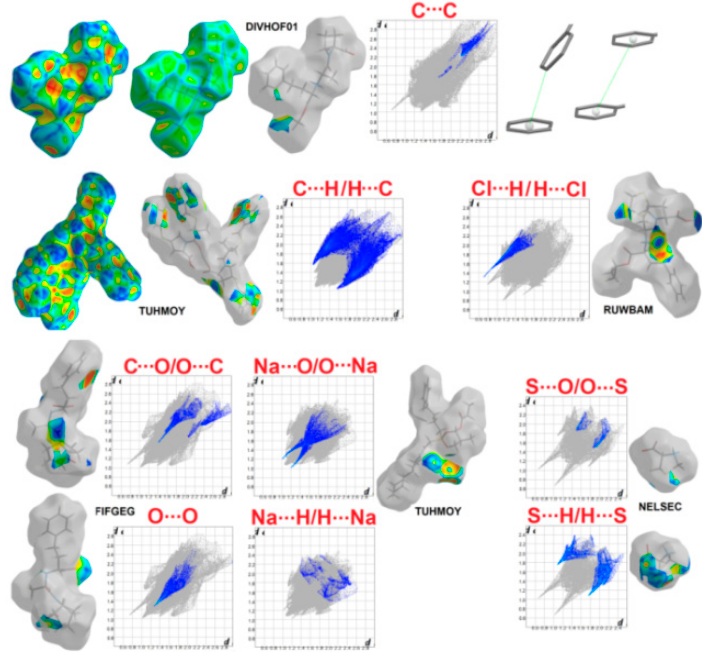
Figure 7. Selected 3-D Hirshfield surface (HS) maps and 2-D fingerprint plots (FPs) representing main inter-contacts in the proline-derived crystals.